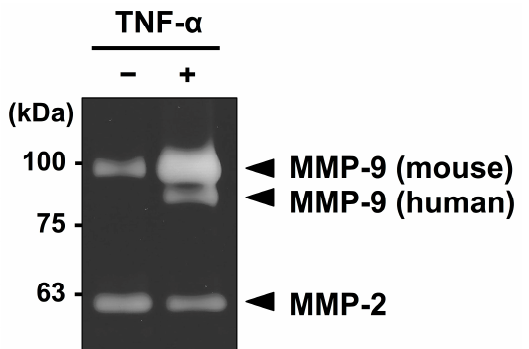
Figure 1. Zymographic analysis of MMPs in the conditioned medium of the co-culture of MKN1 and mesothelial cells after TNF-α treatment. A suspension of MKN1 cells (5 × 10 4 cells/0.2 mL) in ASF104 medium was added to a monolayer of murine peritoneal mesothelial cells in a 96-well culture plate and the cells were cultured with/without TNF-α (10 ng/mL) for 48 h. The culture supernatant was analyzed by gelatin zymography.